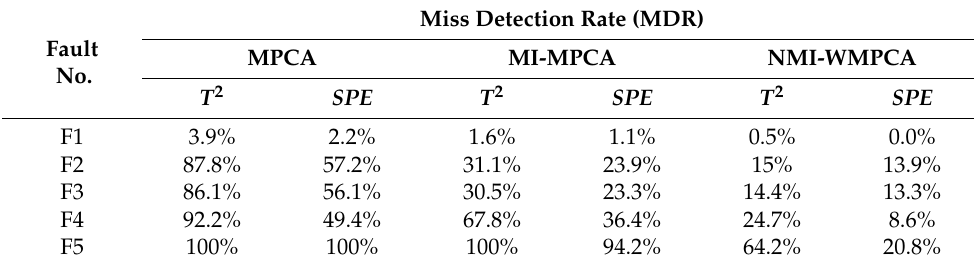
Miss Detection Rate (MDR)